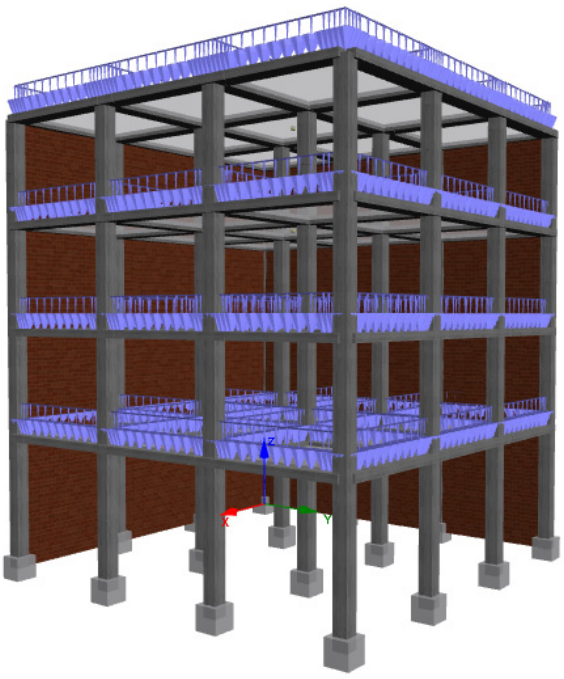
Figure 6. Perspective view of the model.